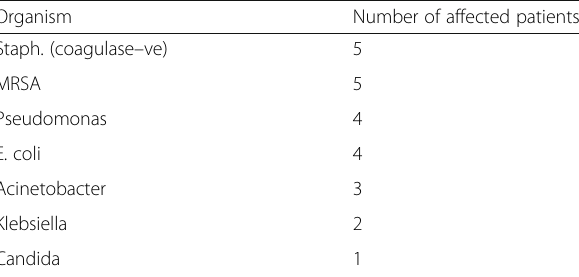
Table 2 Pathogens responsible for post-ischemic stroke pneumonia in our study patients Organism